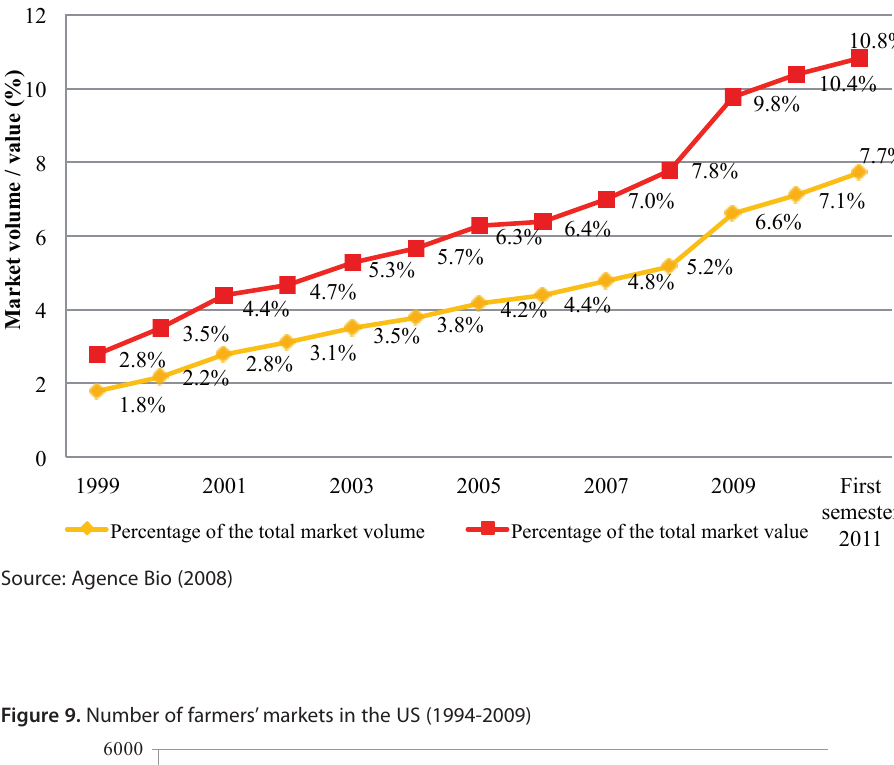
Figure 9. Number of farmers’ markets in the US (1994-2009)